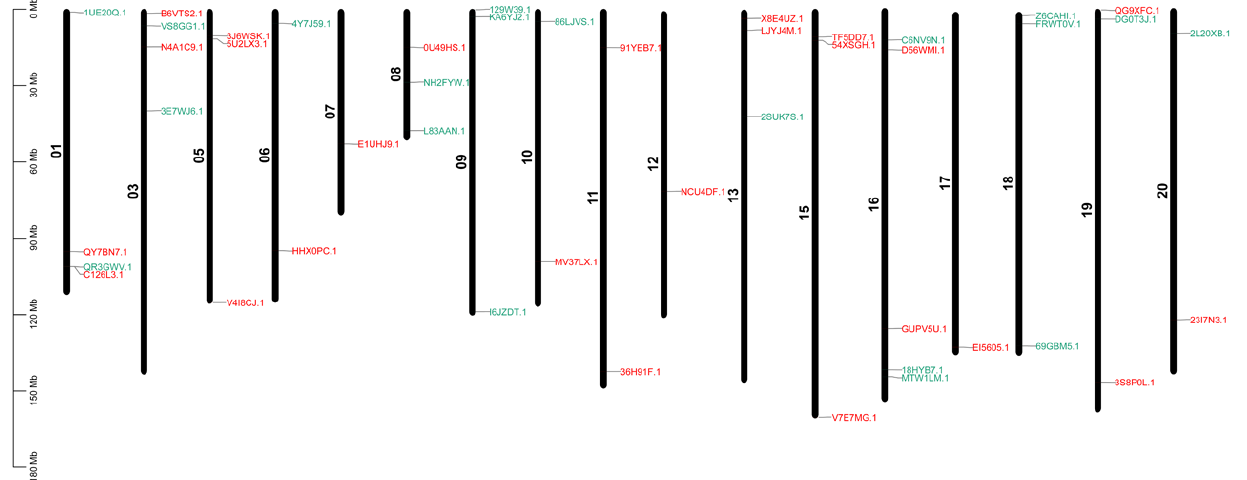
Figure 5. Chromosome distribution of all identified GATA family members in A. hypogaea L. Red and green indicate gene located on the plus and minus strand of chromosome, respectively.